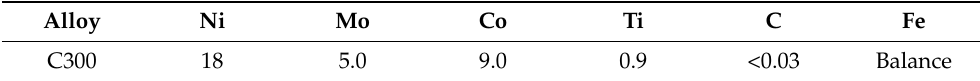
Table 1. Composition of C300 steel in weight percent (nominal).